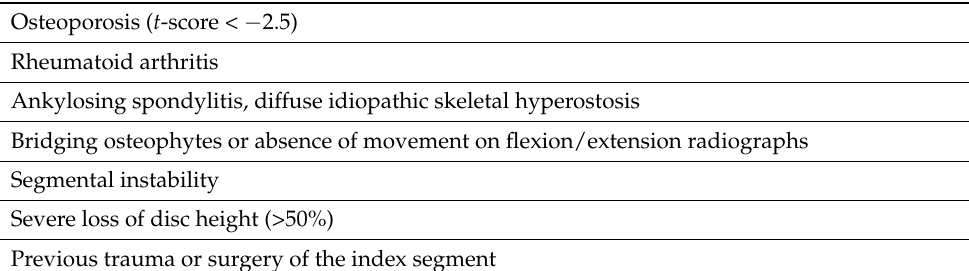
are summarized in Table 2. Table 2. Contraindications for cervical disc